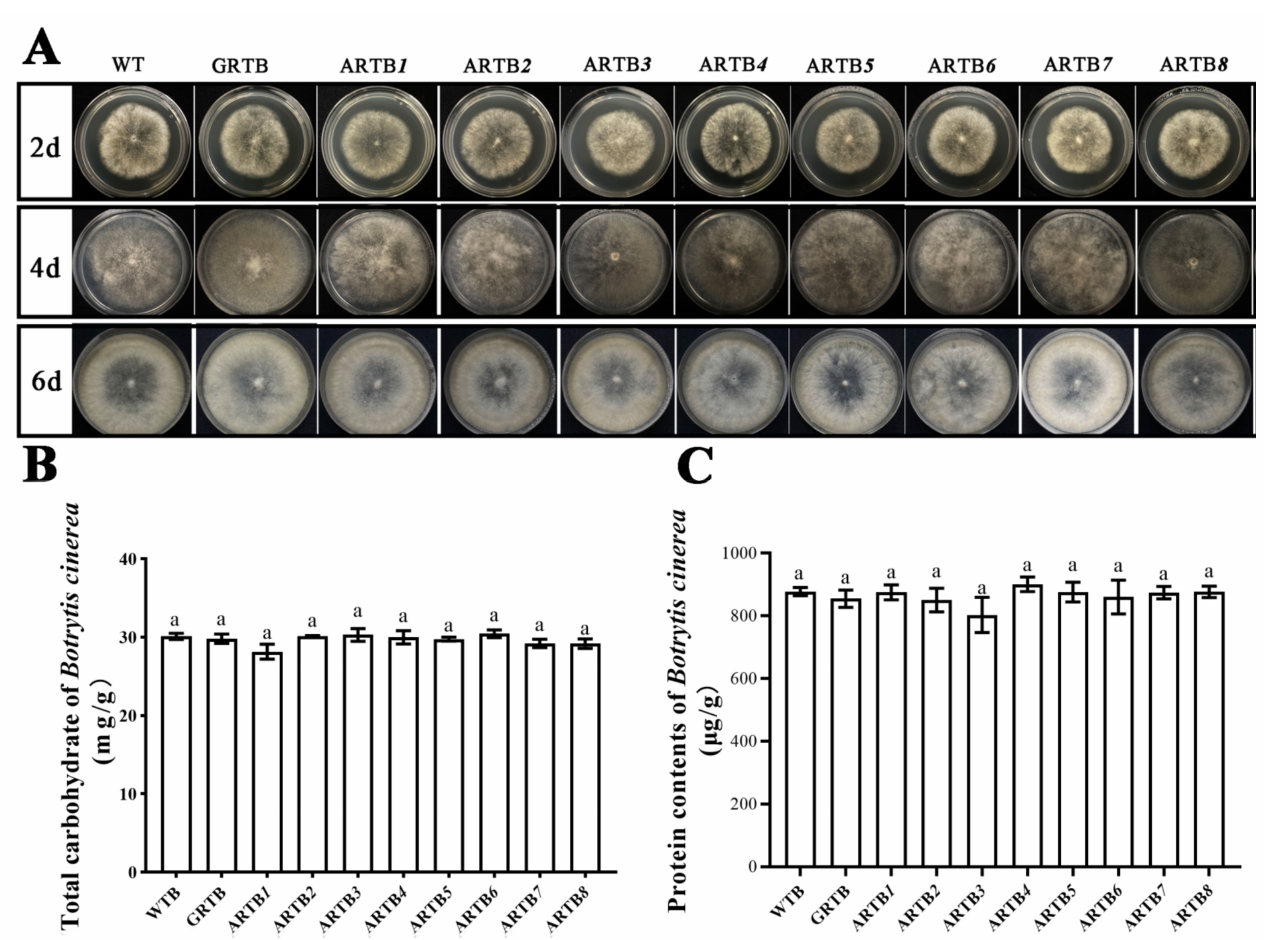
Figure 2. Growth, carbohydrate content, and protein content of Ab-far-n hpRNA transgenic Botrytis cinerea . ( A ) Growth of transgenic B. cinerea . ( B ) Total carbohydrate contents in transgenic B. cinerea . ( C ) Protein contents in transgenic B. cinerea . WTB, wild-type B. cinerea ; GRTB, eGFP hpRNA transgenic B. cinerea ; ARTB 1 -ARTB 8 , Ab-far-1 — Ab-far-8 hpRNA transgenic B. cinerea . Values are means ± standard error, n = 6. Same lowercase letters denote values that are no significantly different from each other ( p < 0.05; Tukey’s